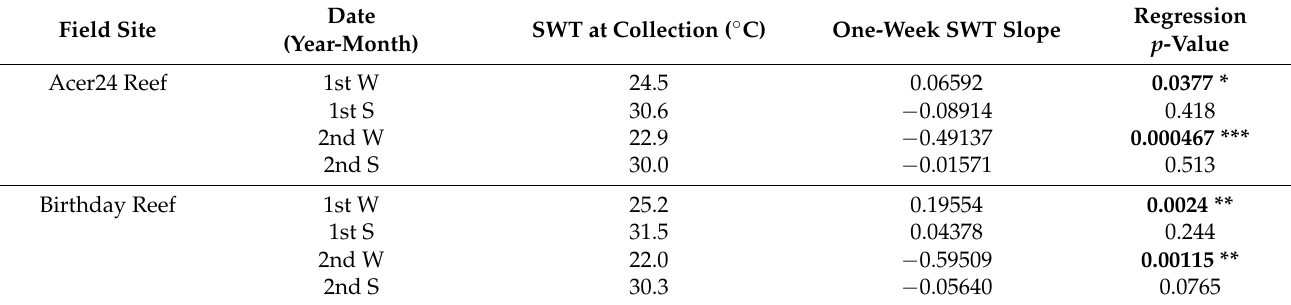
Table 3. Seawater temperatures reported at the date of collection at the offshore site (Acer24 Reef) and the inshore site (Birthday Reef) are displayed in the table. The slope of temperature change during the week preceding sampling and p -value associated with the linear regression are also displayed. Note: first summer (1st S) and winter (1st W) vs. second summer (2nd S) and winter (2nd W) are shown. Asterisk indicate level of significance: * ≤ 0.05, ** ≤ 0.01, *** ≤ 0.001; Significant values are in